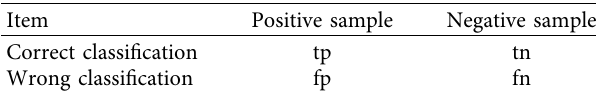
Table 1: Evaluation parameters of classification